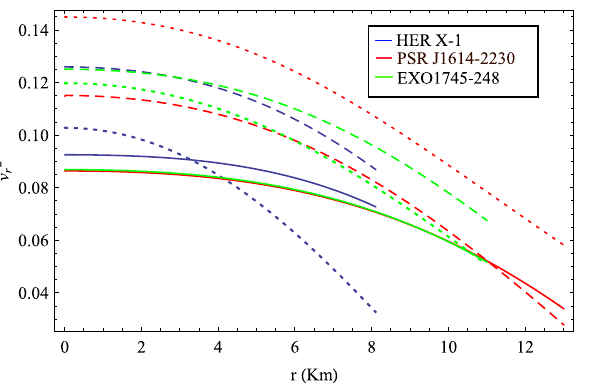
Fig. 8 Radial variation of square of the electric field ( E 2 ) for different compact objects as indicated in the figure. Here plots with solid, dashed and dotted lines correspond to D = 4 , 5 and 6 respectively. To obtain the plots we choose (i) α = 0 . 4, γ = 0 . 45 when D = 4; α = 0 . 3, γ = 0 . 25 when D = 5 and α = 0 . 25, γ = 0 . 2 when D = 6 for HER X-1, (ii) α = 0 . 4, γ = 0 . 5 when D = 4; α = 0 . 3, γ = 0 . 25 when D = 5 and α = 0 . 2, γ = 0 . 15 when D = 6 for PSR J1614-2230, (iii) α = 0 . 4, γ = 0 . 5 when D = 4; α = 0 . 3, γ = 0 . 2 when D = 5 and